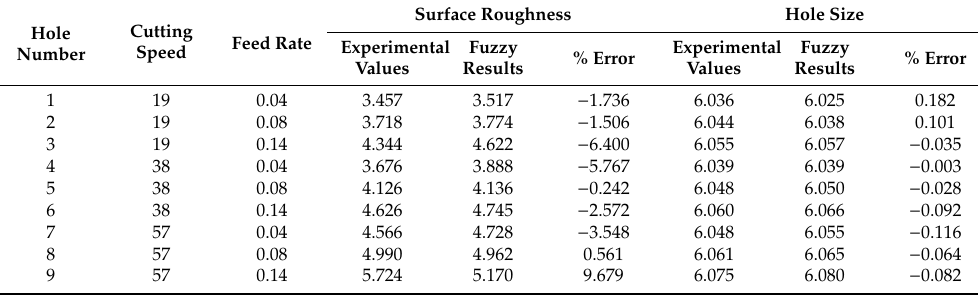
Table 10. Experimental values and fuzzy results with percentage errors.